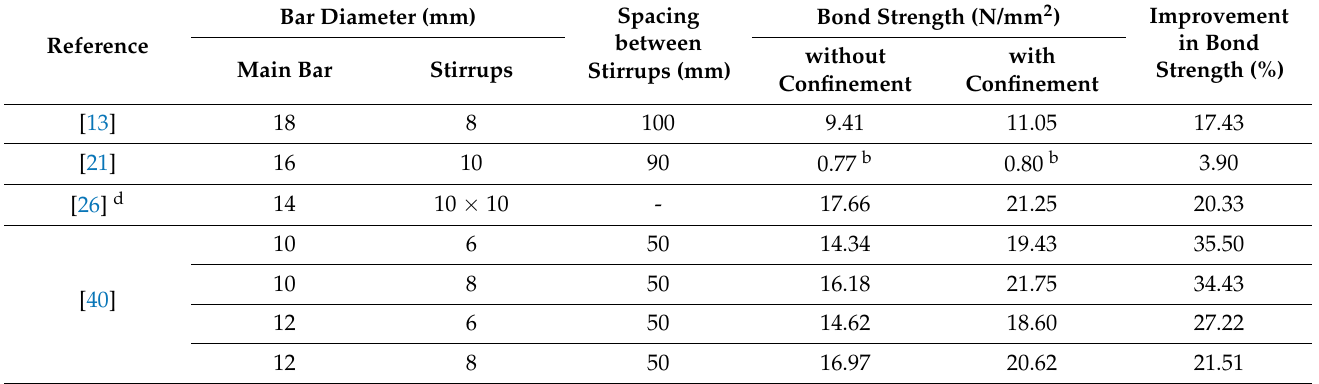
Table 7. Bond strength comparison with confinement